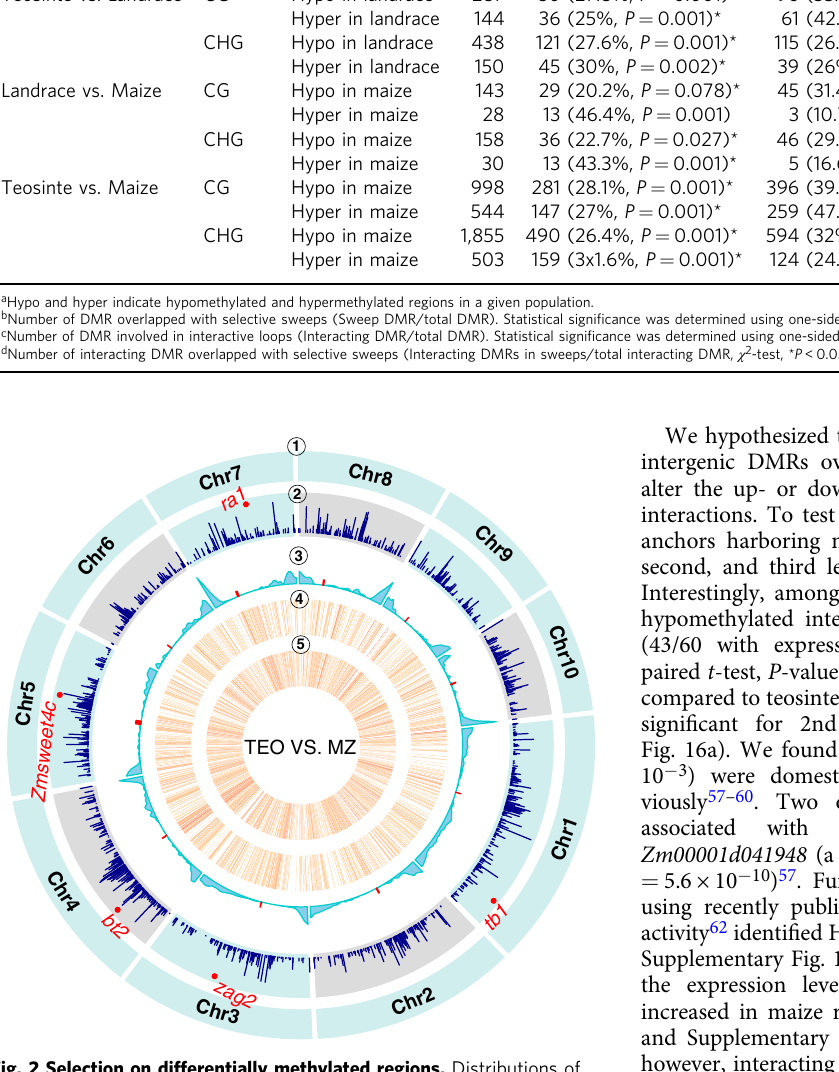
Fig. 2 Selection on differentially methylated regions. Distributions of teosinte-maize selective sweeps, DMRs, and other genomic features across ten maize chromosomes. From outer to inner circles were as follows: ① chromosome names, ② selective sweeps detected between modern maize and teosinte, ③ the recombination rate and the density of DMRs (number per 1 Mb) between modern maize and teosinte in ④ CG and ⑤ CHG contexts. Red dots in circle 3 denote the centromeres. Source data are provided as a Source Data fi